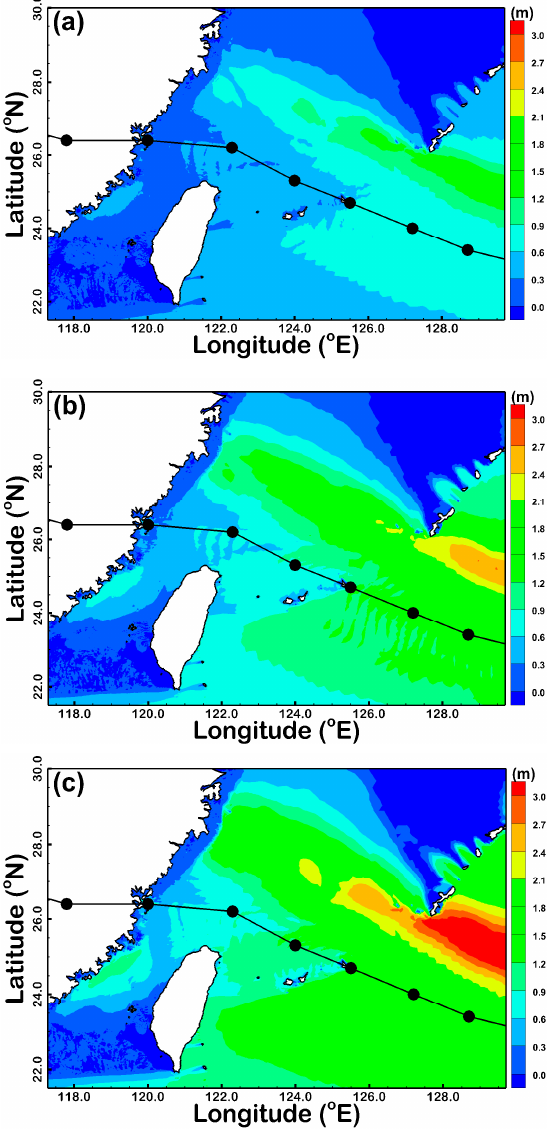
Figure 5. Spatial distribution of the difference in maximum SWH using the winds from ( a ) H_5R max and H_4R max , ( b ) H_6R max and H_4R max and ( c ) H_7R max and H_4R max during the passage of Super Typhoon Maria in 2018.